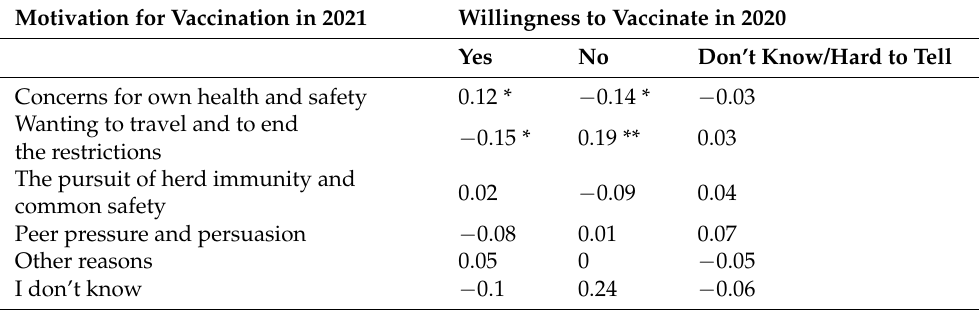
Table 3. Correlation between willingness to vaccinate in 2020 and motivations for vaccination in 2021. Motivation for Vaccination in